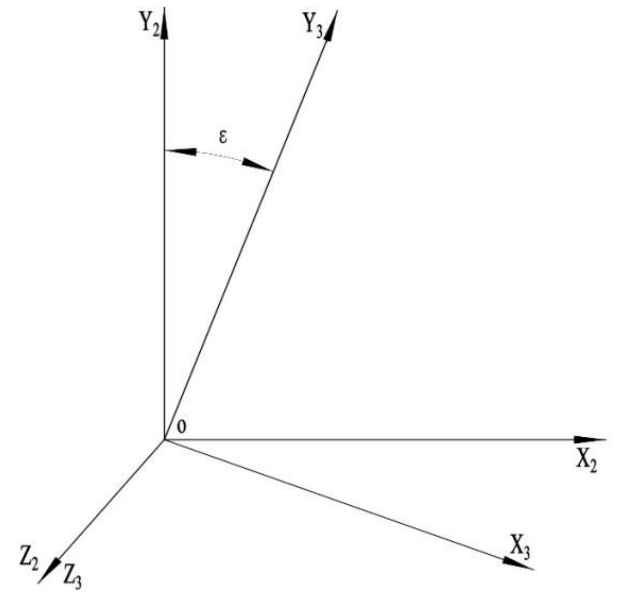
Figure 5. The coordinate conversion between S 2 and S 3 .